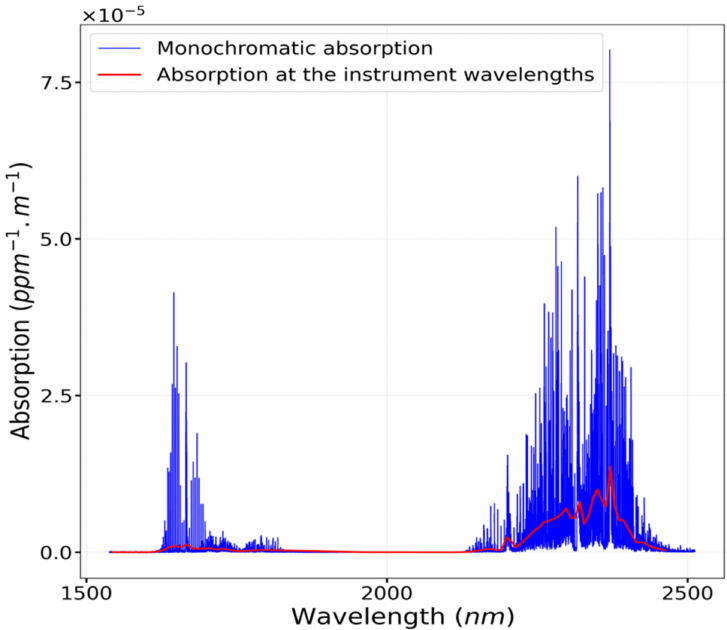
Figure 1. Methane monochromatic absorption in ppm − 1 · m − 1 from the PNNL database (blue line) convolved with the PRISMA spectral response function (red line).